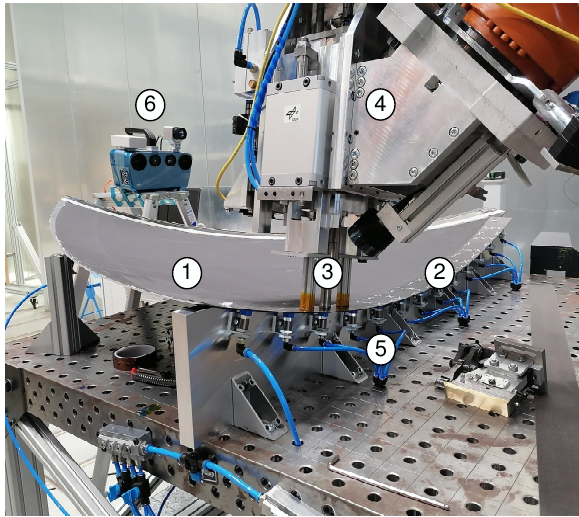
Figure 2. Experimental ultrasonic welding setup showing a rear pressure bulkhead segment (1) to be joined with external doubler patches (2), under the robot-guided (4) ultrasonic welding tool (3), fixed on an anvil with suction cups (5), and our camera system